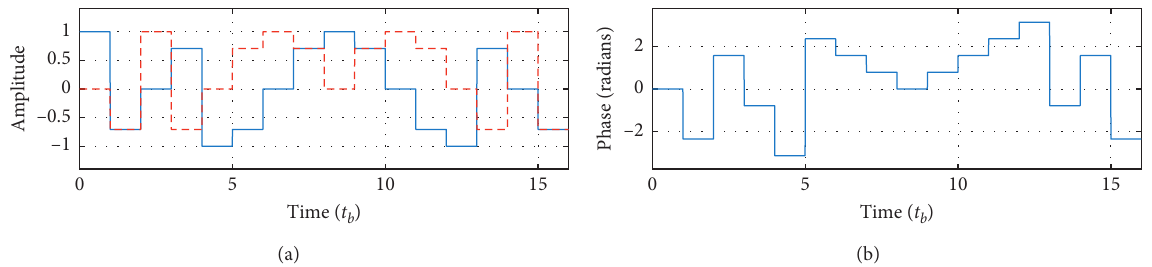
Figure 20: A pulse of a 16-chip P1 poly-phase waveform: (a) I / Q of the waveform (solid and dashed lines are I and Q , respectively) and (b) the phase in each chip of the signal.